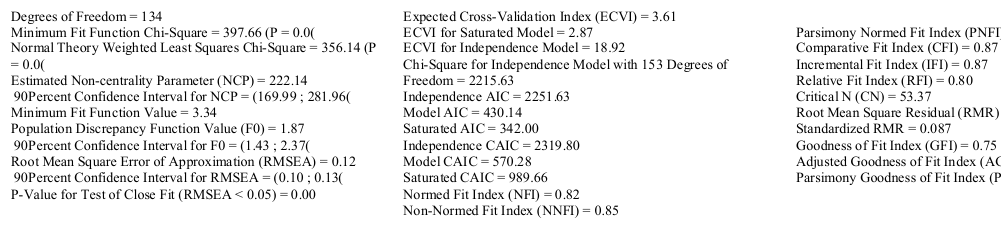
Parsimony Normed Fit Index (PNFI) = 0.72 Comparative Fit Index (CFI) = 0.87 Incremental Fit Index (IFI) = 0.87 Relative Fit Index (RFI) = 0.80 Critical N (CN) = 53.37 Root Mean Square Residual (RMR) = 0.087 Standardized RMR = 0.087 Goodness of Fit Index (GFI) = 0.75 Adjusted Goodness of Fit Index (AGFI) = 0.68 Parsimony Goodness of Fit Index (PGFI) =